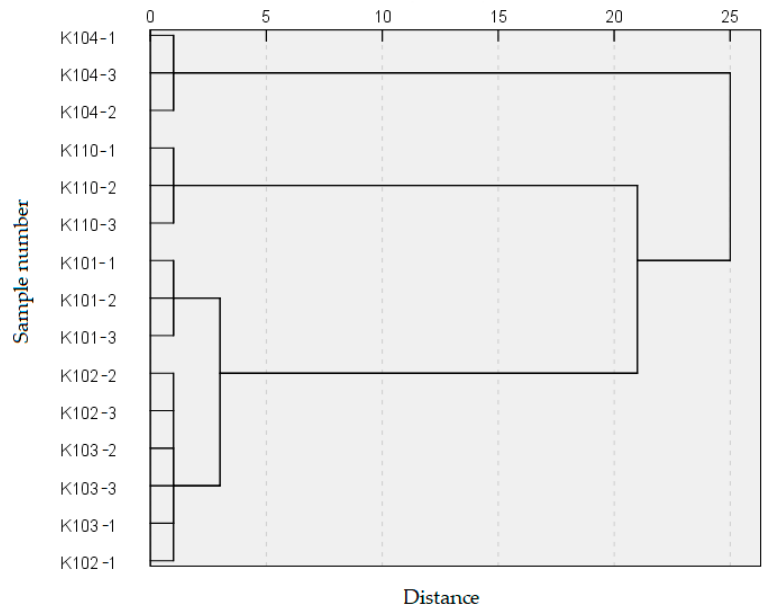
Figure 2. Unsupervised hierarchical clustering of Nongxiang Tieguanyin based on the relative content of 18 differential variables. Three technical replicates were represented for each sample with “-1”, “-2” and “-3” following the sample number.